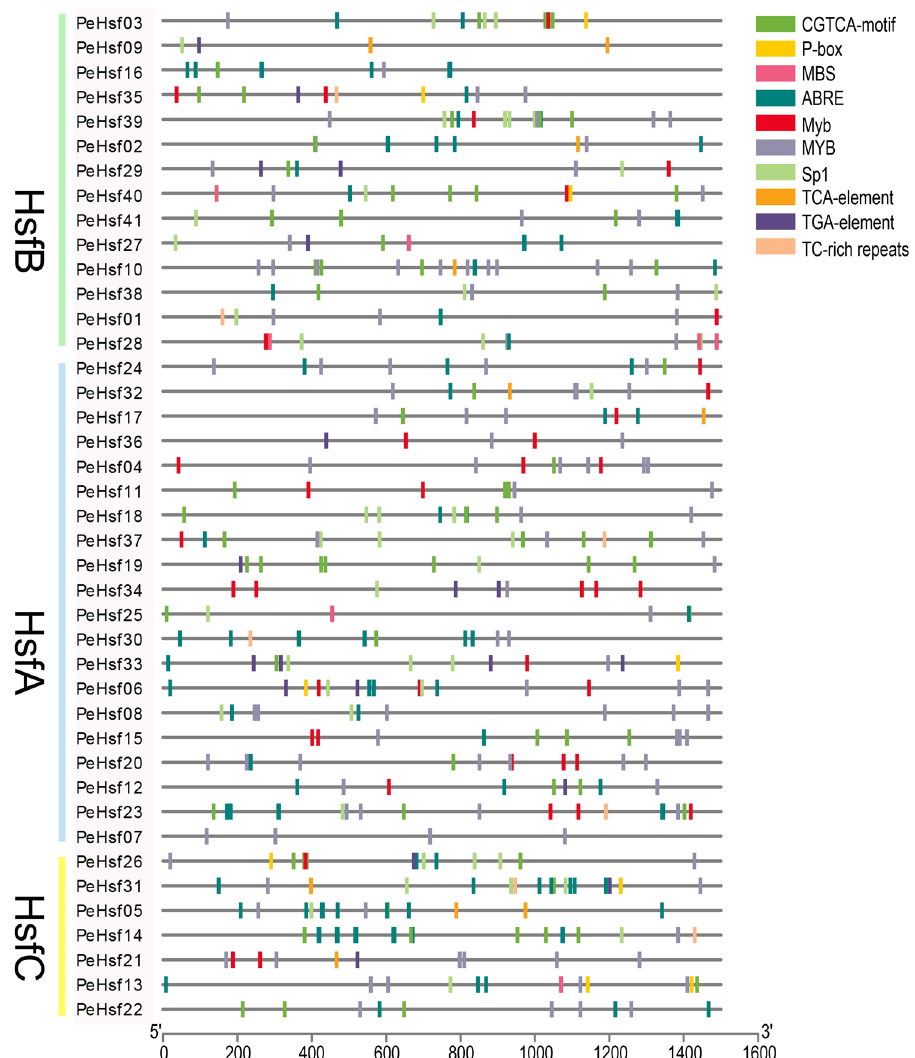
Figure 9. Diagram of cis -acting elements identified in the 1,500-bp upstream promoter regions of the PeHsf genes. Rectangular boxes of different colors represent individual cis -acting elements, and some elements overlap with one another. PlantCARE (http:// bioin forma tics. psb. ugent. be/ webto ols/ plant care/ html/) was used to identify cis-acting elements in the 1500-bp promoter region upstream of each gene’s transcription start site, and the results were visualized using TBtools